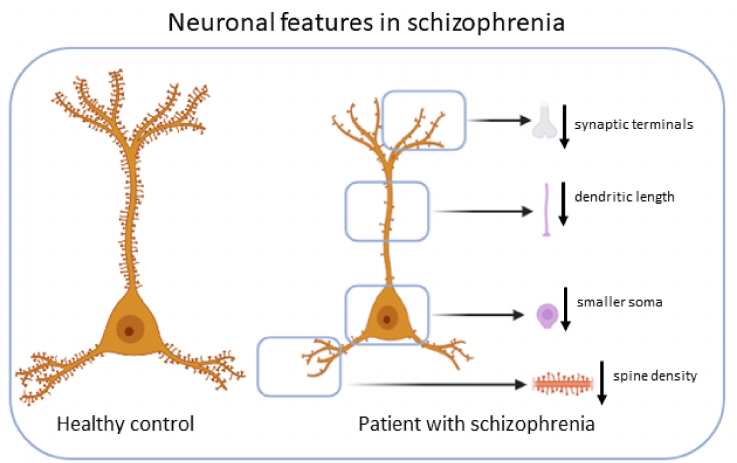
Figure 1. Neuronal features in SZ. Cortical pyramidal neurons from subjects with schizophre- nia exhibit smaller soma volume, decreased spine density, decreased dendritic length and decreased